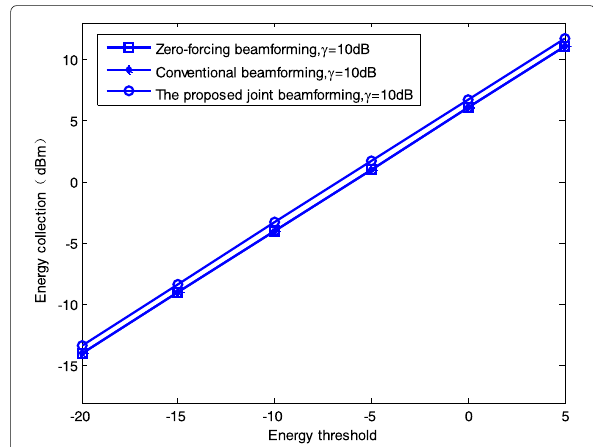
Fig. 8 The relation between energy collection and energy